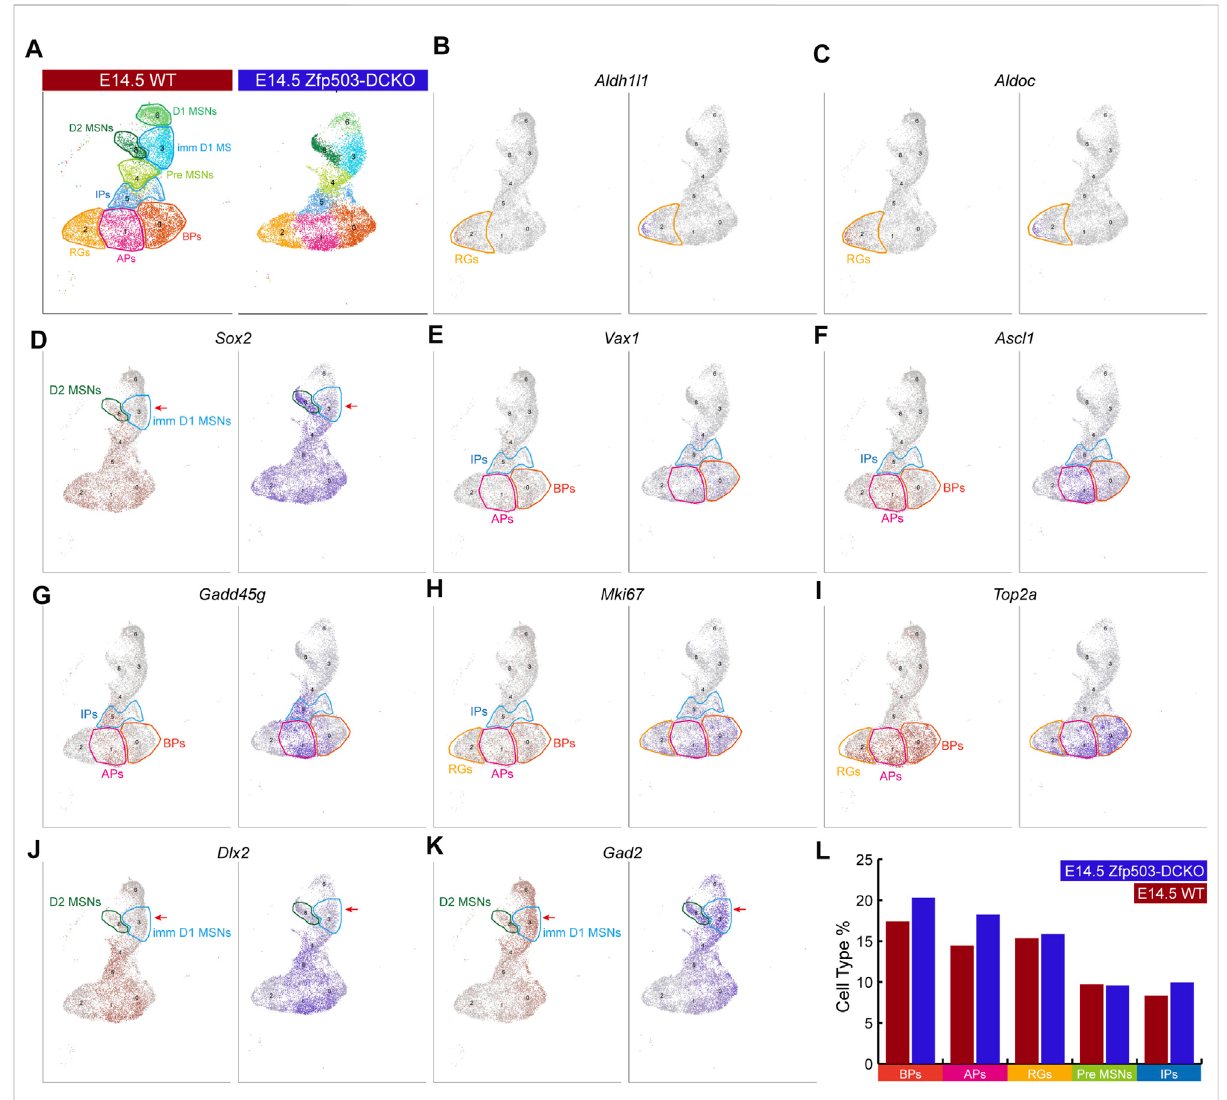
FIGURE 3 Zfp503 regulates the differentiation of progenitor cells. (A) The major cell populations of the LGE at E14.5. (B – C) There were no signi fi cant differencesintheexpressionof Aldh1l1 and Aldoc betweenWTand Zfp503 -DCKOmice. (D – K) Theexpressionof Sox2 , Vax1 , Ascl1 , Gadd45g , Mki67 , Top2a , Dlx2, and Gad2 was increased in the Zfp503- mutant sample compared to the WT sample. (L) The percentages of BPs, APs, and IPs were increasedbutthepercentagesofRGsandPre-MSNswerenotalteredinthe Zfp503 -DCKOsamplecomparedtotheWTsample.Abbreviations: radial glia cells (RGs); apical progenitors (Aps); basal progenitors (BPs); intermediate progenitors (IPs); premature MSNs (Pre-MSNs); immature D1 MSNs (Imm D1 MSNs).